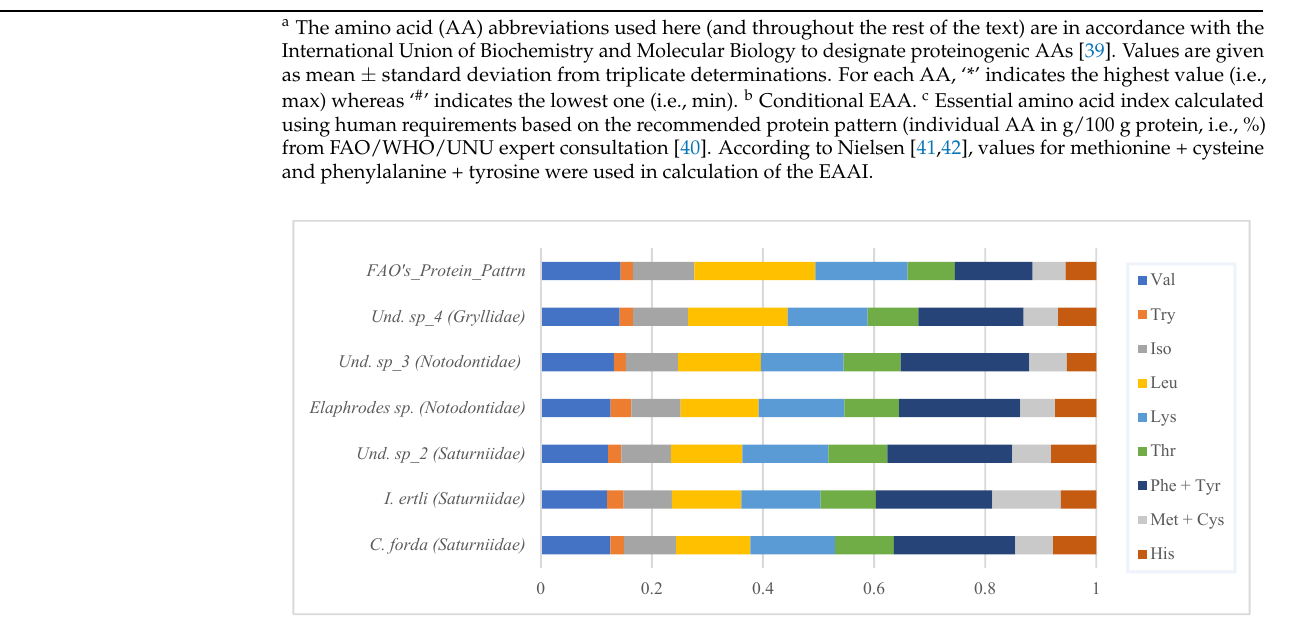
Table 4. EAA ratios calculated based on the FAO/WHO pattern for preschool children (2–5 years old), estimated AA score, and limiting AA of the selected insects.